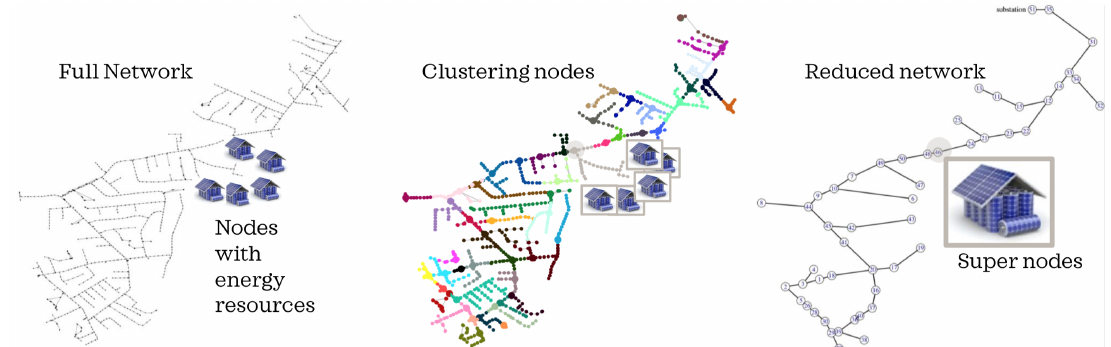
Figure 6. Process for network reduction of electrical circuits by partitioning the network into clusters of similar nodes with the same color. The largest nodes in each cluster is the designated